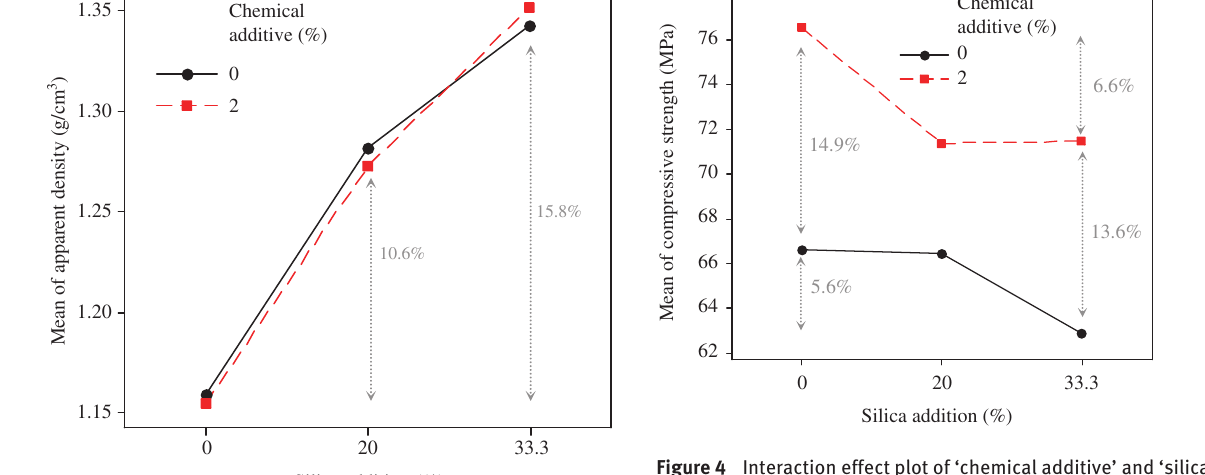
Figure 4 Interaction effect plot of ‘chemical additive’ and ‘silica addition’ for the compressive strength